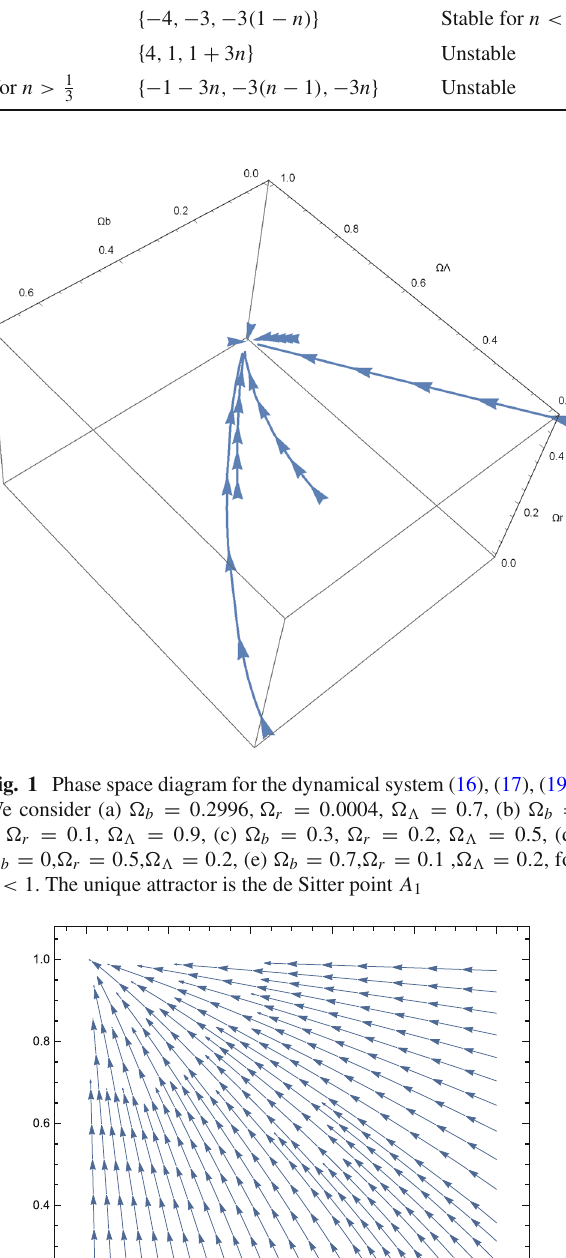
Table 1 Critical points and physical quantities for Case A Point